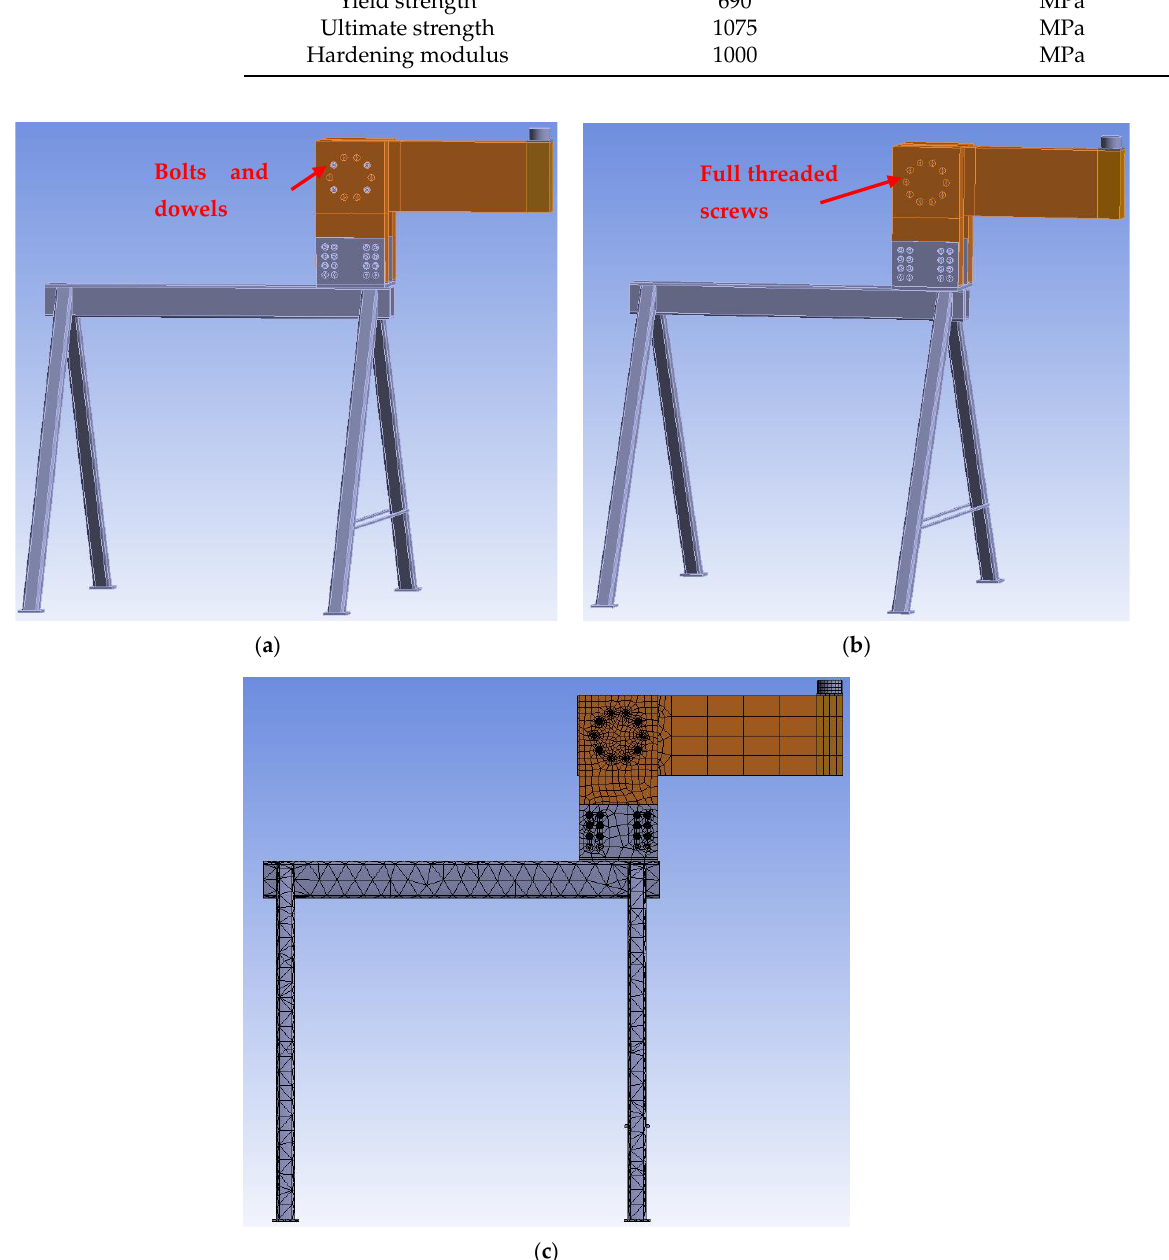
Figure 7. Numerical models: ( a ) Experiment A, bolts and dowels; ( b ) Experiment B, fully threaded screws; ( c ) finite element mesh in the overall model view.